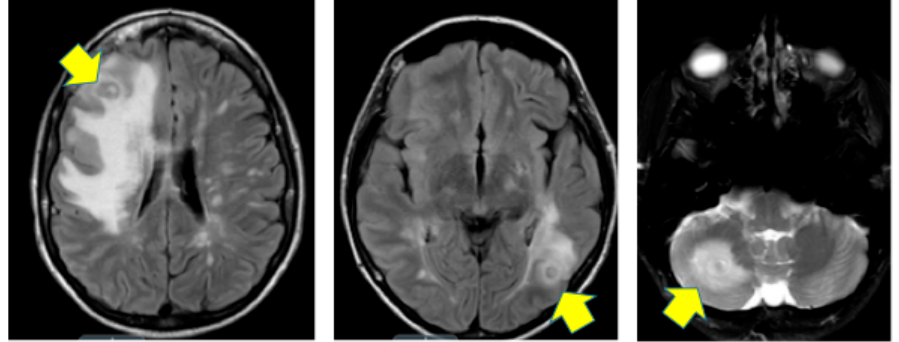
Figure 1. Proven cerebral aspergillosis in a 30-year old female diagnosed within 45 days after orthotopic liver transplantation. MR of the brain shows hyperintense T2 and FLAIR signal throughout the cerebral white matter, and deep gray nuclei structures with discrete ring enhancing lesions and surrounding edema seen in the left occipital lobe and right cerebellum